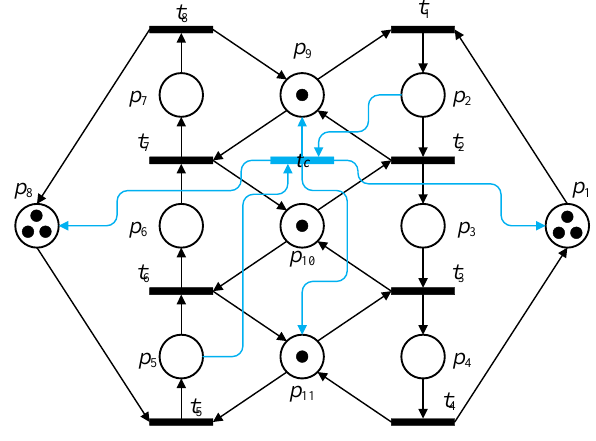
Figure 4. The controller for Figure 2.